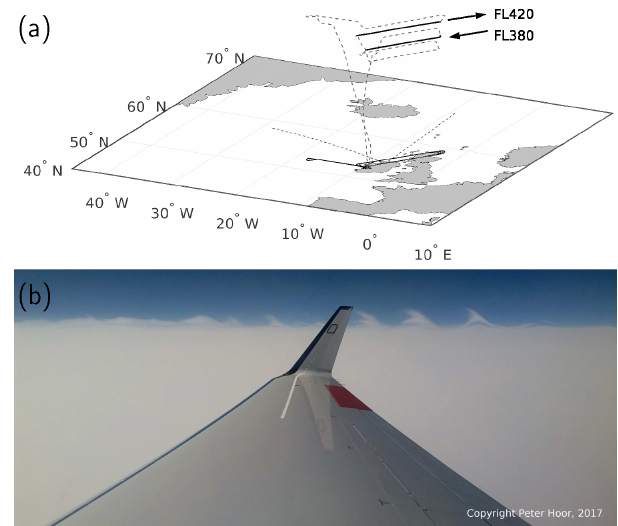
Figure 2. (a) Three-dimensional flight track of WISE RF07, high- lighting the flight legs important for this study. The arrows point in the direction of the flight on the respective levels. The dashed lines on the surface map show the angle of view of the photo shown in panel (b) . (b) Photo taken on board HALO at 15:03UTC during WISE RF07 showing Kelvin–Helmholtz cloud billows on top of a cirrus cloud